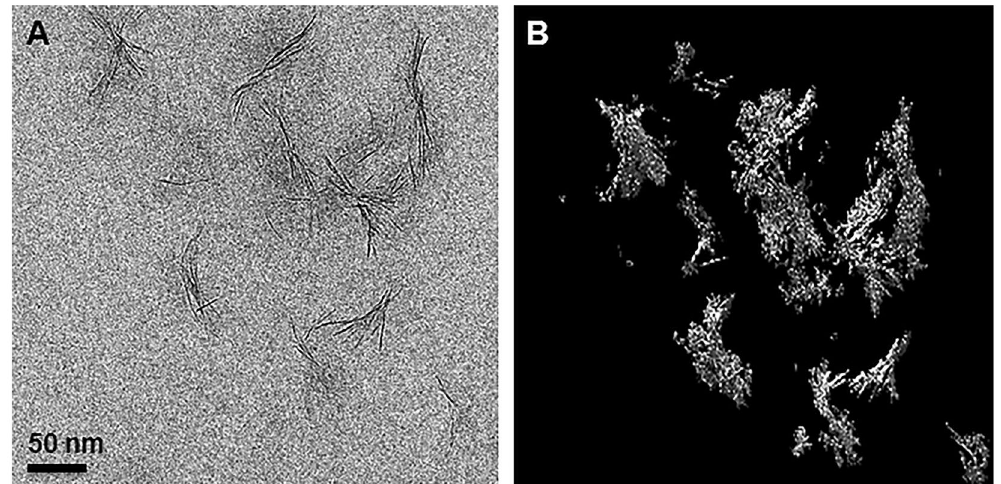
Figure 5. ( A ) Snapshot from a tomogram of an isolated aggregate of sauconite nanocrystals from a less dense area in the section for 20 h synthesis with 1.0 M succinate at pH 0 9.0 and 90 °C ( B ) 3D reconstruction of ( A ). See Video M4 in the Supporting